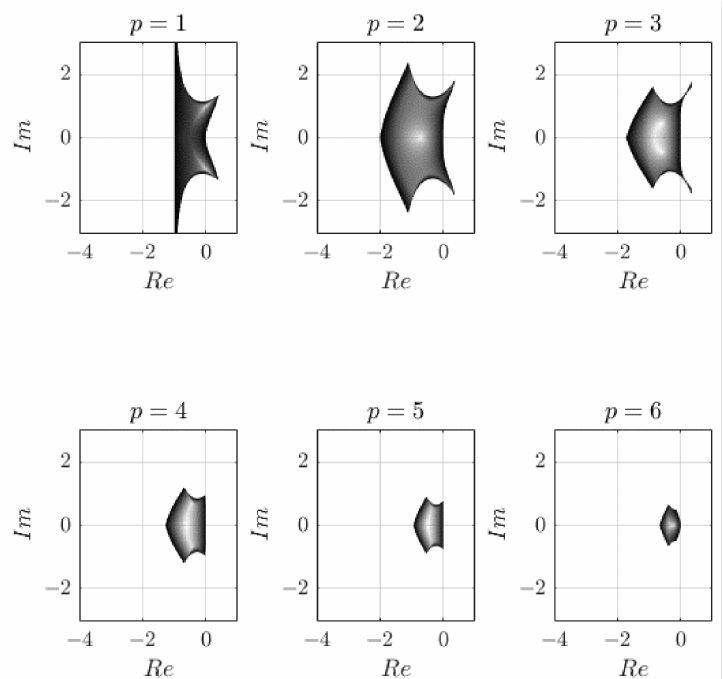
Figure 2. Stability regions of the semi-explicit Adams–Bashforth–Moulton methods with k = 1.